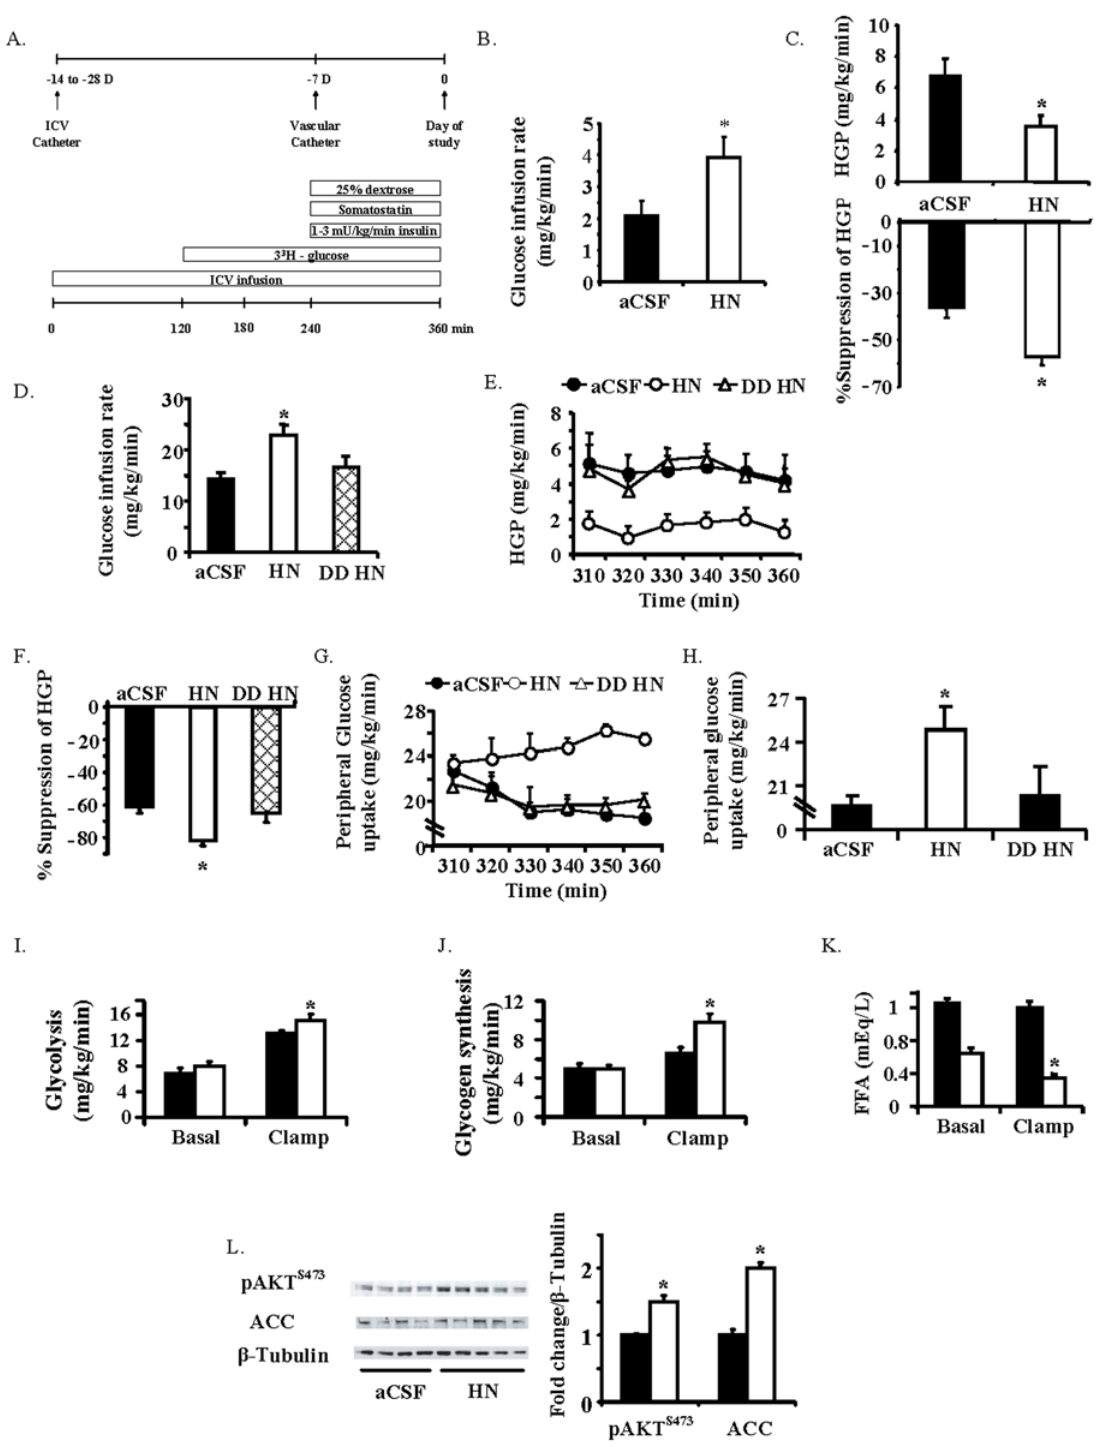
Figure 2. ICV HN increases peripheral insulin sensitivity. A) Schematic representation of the experimental design for the ICV studies; the upper panel demonstrates the time line for the surgical procedures and the lower panel demonstrates the protocol on the day of the clamp. B) Glucose infusion rate (GIR) and C) Hepatic glucose production (HGP) and degree of suppression of HGP by artificial cerebrospinal fluid (aCSF) and 0.16 m g/kg/min HN infusions ( n =5 each) during a basal pancreatic clamp. D) GIR, E) HGP and F) degree of HGP suppression during a hyperinsulinemic clamp with ICV infusion of aCSF, HN and a DDHN peptide ( n =7 each). G) Time course and H) last hour average of effects of ICV aCSF, HN and DDHN on peripheral glucose uptake during a hyperinsulinemic clamp. Effect of aCSF (black bars) and HN (white bars) on I) glycolysis, J) glycogen synthesis, and K) suppression of free fatty acids (FFA) in response to insulin. L) pAKT and acetyl CoA carboxylase (ACC) in skeletal muscle during insulin clamp in response to ICV aCSF and HN ( n =7 each). Values are means 6 SE. *Significantly different from other experimental groups, P , 0.05.